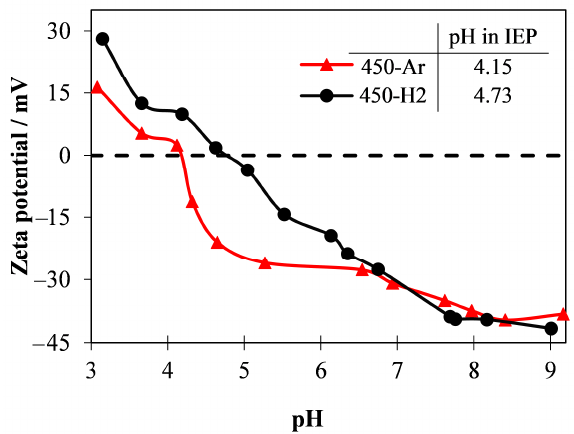
Figure 5. The zeta potential versus pH of TiO 2 _450-Ar and TiO 2 _450-H 2 suspensions. Hydrogenation of titania can conduct to changes in its optical properties through the formation of some localized electron states induced by formation of oxygen vacancies and Ti 3+ defects [21]. The colour of the titania hydrogenated samples can change from white to pale yellow, yellow, brown, blue, grey or black, depending on the preparation methods and conditions [21]. The prepared titania samples under hydrogen treatment above 450 °C revealed change of colour onto brownish (at 500 °C) and grey (at 600 °C). The UV- Vis/DR absorption spectra of the studied samples were illustrated in Figure 6.